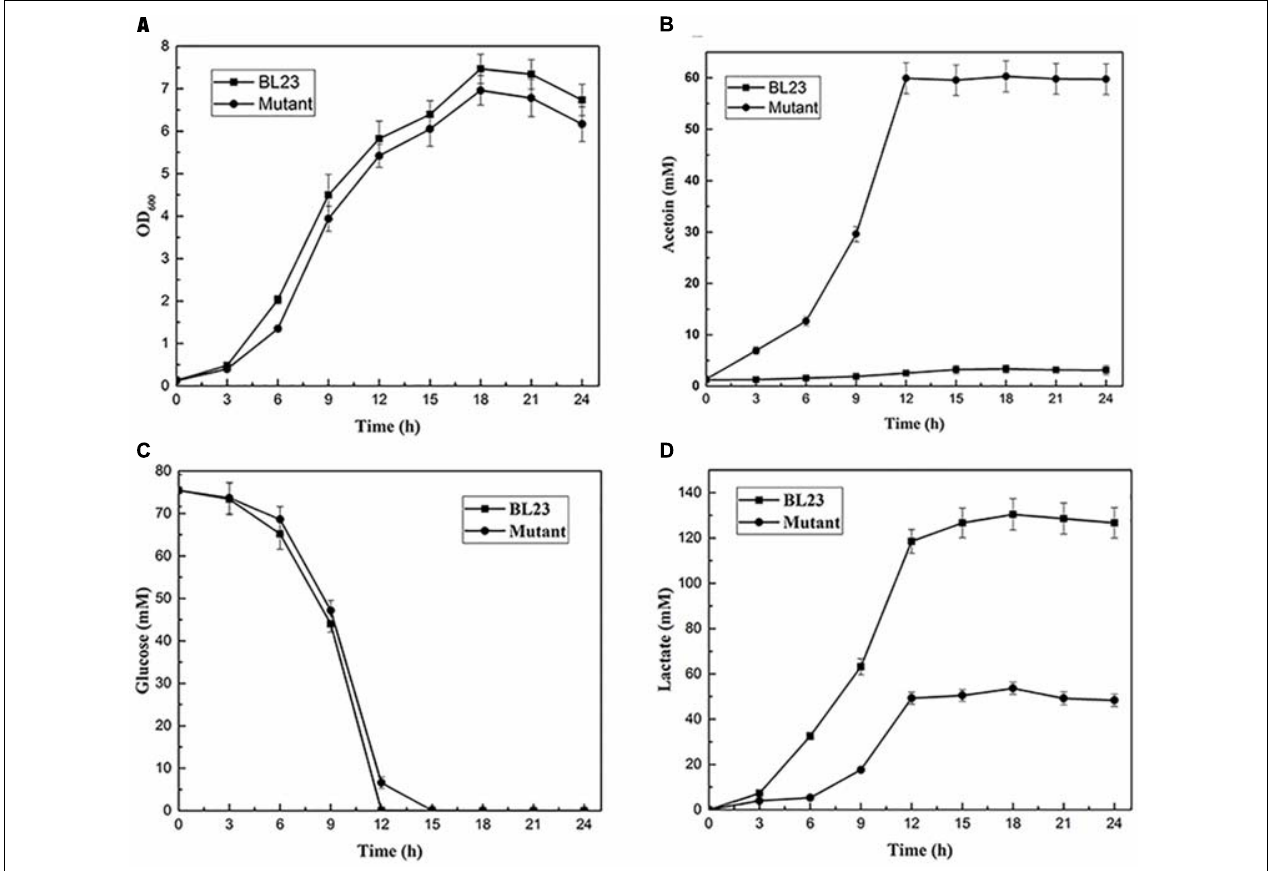
FIGURE 6 | Fermentation profiles of the quadruple deletion mutant compared to the wild-type BL23 in MRS medium under shaking conditions. (A) Cell growth; (B) Acetoin production; (C) Glucose consumption; (D) Lactate production. Results are the averages from three independent experiments with standard deviations indicated by error